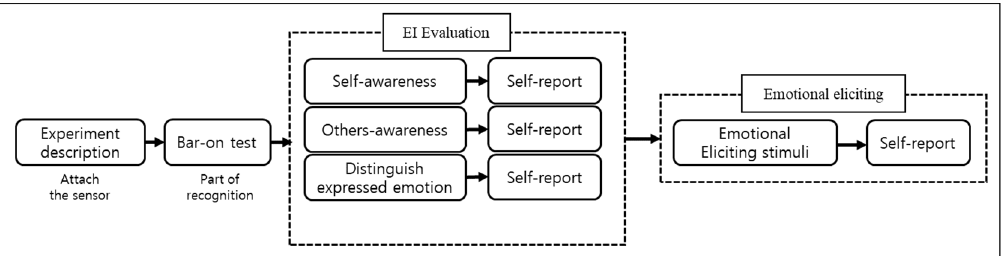
Figure 7. The overall experimental protocol of Experiment 4.